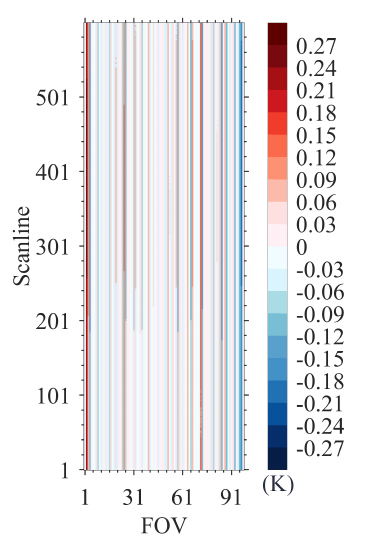
Figure 11. Spatial distribution of the: ( a ) striping noise (unit: K); and ( b ) “O − B” (unit: K) after the striping noise mitigation for MWHS-2 Channel 3 on 2 October 2021.